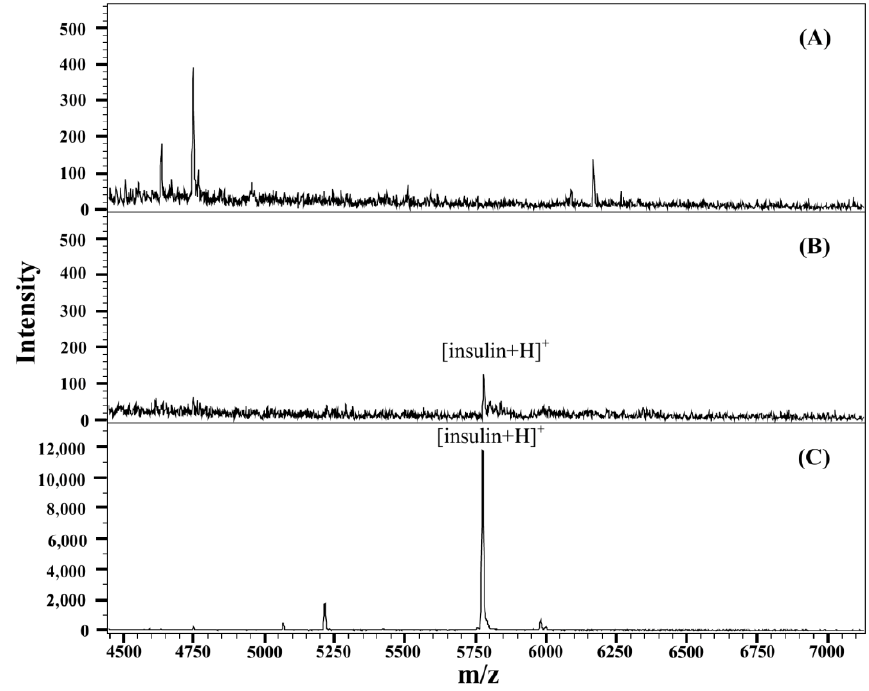
Figure 8. Mass spectra of human urine samples. ( A ) blank urine without the EME, ( B ) insulin-spiked urine without the EME, and ( C ) insulin-spiked urine with the EME. Experimental conditions: sample volume, 12 mL; applied voltage, 12 V; stirring rate, 400 rpm; extraction time, 10 min; and insulin, 50.0 nM. Table 2. Within-day and day-to-day precision and accuracy for the EME-MALDI/MS analysis of insulin in urine samples (n = 5).